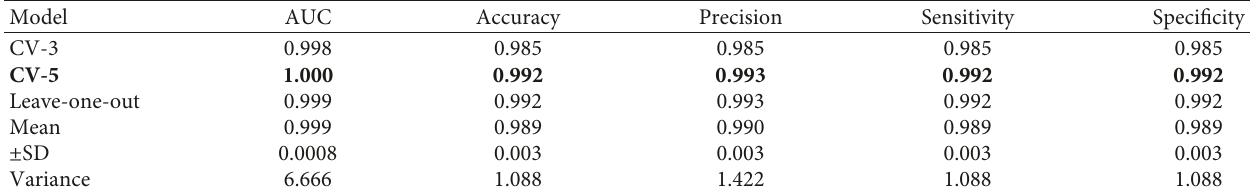
Table 6: Performance of the warm and wet general body temperament and dystemperament of the uterus in AVD using Support Vector Machine- Radial Basis Function (SVM-RBF) classifier.